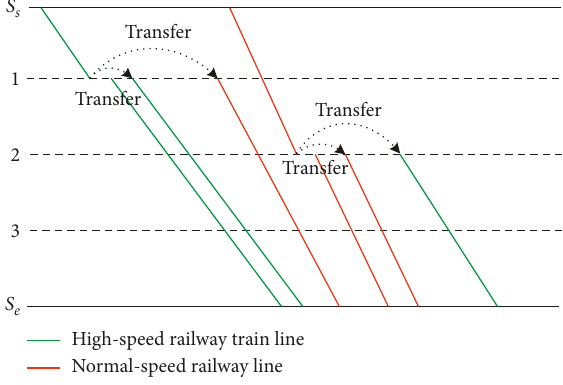
Figure 4: Simplified train timetable considering transfer.